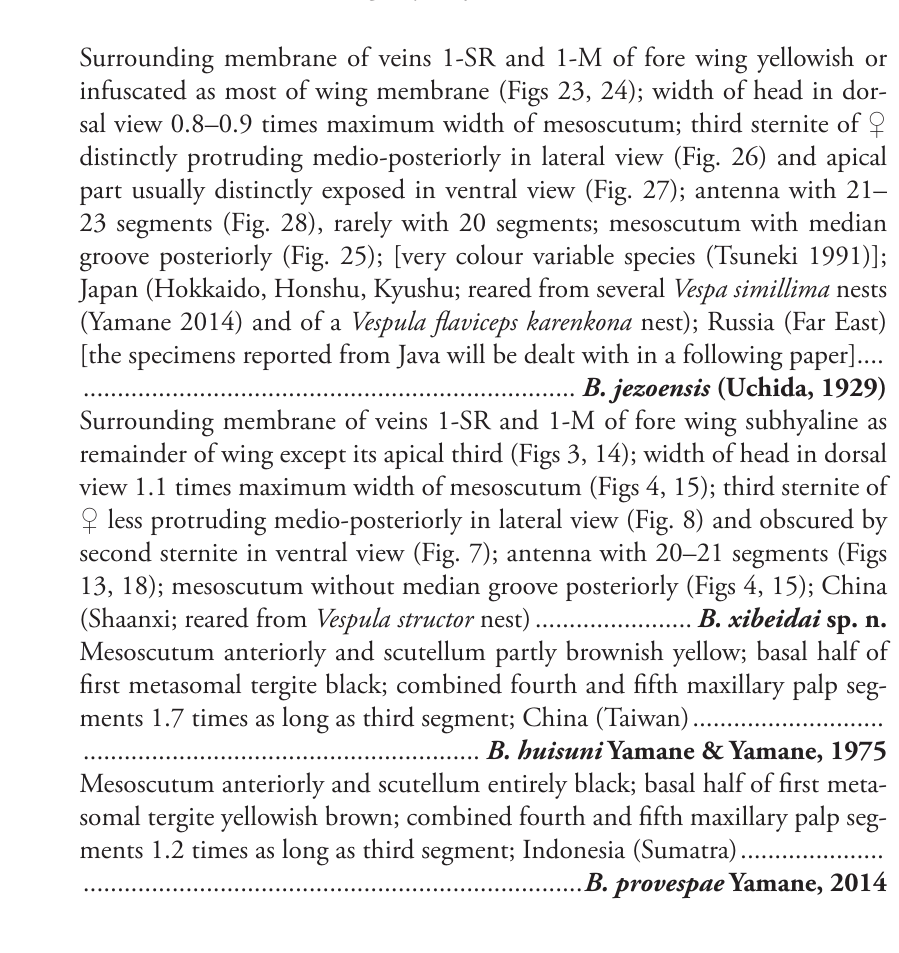
Type material. Holotype, ♀ (NWUX) “NW China: Shaanxi, Fengxian County, Baoji, Jialingjiang Riv[er] Source, 1513 m, 34°25'N 106°94'E, 1.ix.2016, JL. Tan & QQ. Tan, NWUX”, “Reared from nest of Vespula structor (Smith)”. Paratypes: 6 ♀ + 8 ♂ (NWUX, RMNH), same label data. Diagnosis. Left mandible with two subapical teeth, ventral tooth shorter than dorsal tooth; maxillary palp with six segments; width of head in dorsal view 1.05–1.10 times maximum width of mesoscutum (Figs 4, 15); anterior half of scutellum flat and at same level as mesoscutum; metanotum with large protuberance and long setae; wing membrane near veins 1-SR and 1-M of fore wing subhyaline as remainder of wing ex- cept darkened apical third of wing (Figs 3, 14); hind basitarsus slender (Fig. 12); fourth and fifth tergites largely smooth and shiny; third sternite of ♀ in ventral view